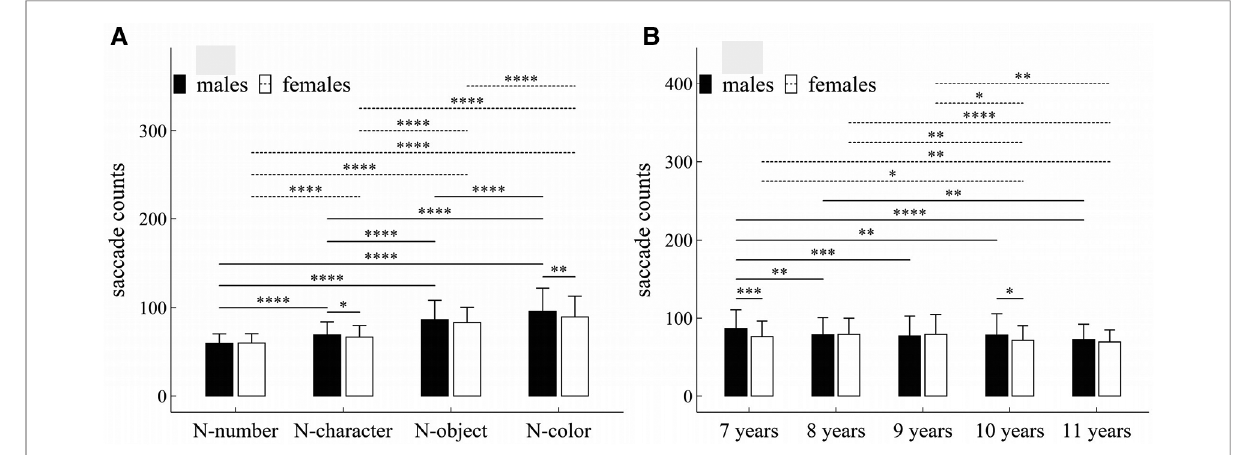
FIGURE 2 In fl uence of task-type, gender and age on saccade counts: ( A ) interactive effect of gender and task-type; ( B ) interactive effect of age and task-type. * p <0.05; ** p <0.01; *** p <0.001; **** p <1×10 − 4